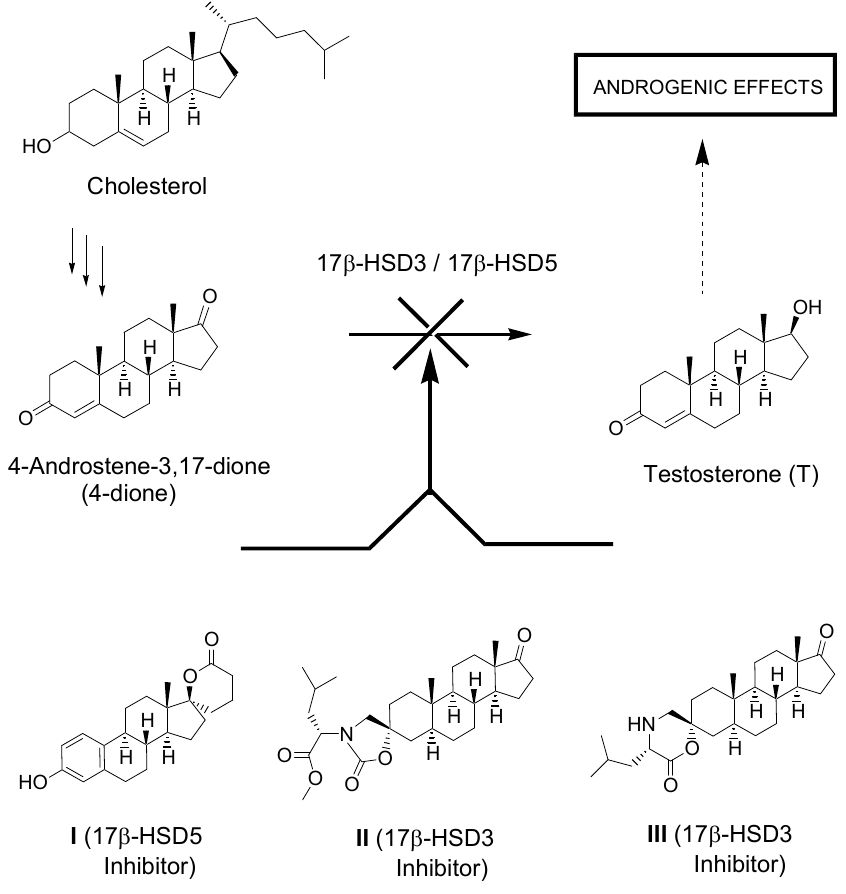
Figure 1. Role of 17 β -HSD3 and 17 β -HSD5 in the synthesis of the androgenic hormone